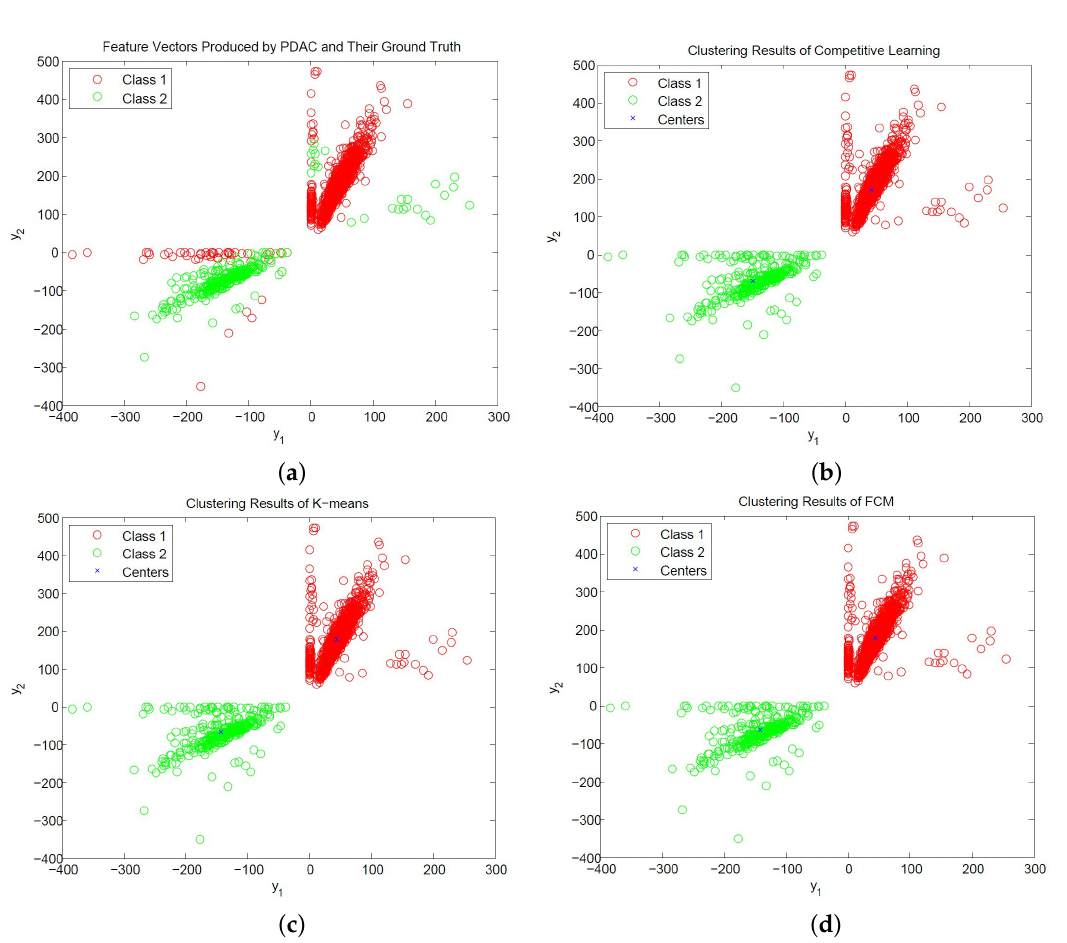
Figure 13. The distribution of PDAC feature vectors of spikes and the results of CL, K-means and FCM clustering for SNR = 1 dB. ( a ) Ground truth of neuron spikes; ( b ) clustering results produced by CL; ( c ) clustering results produced by K-means; ( d ) clustering results produced by